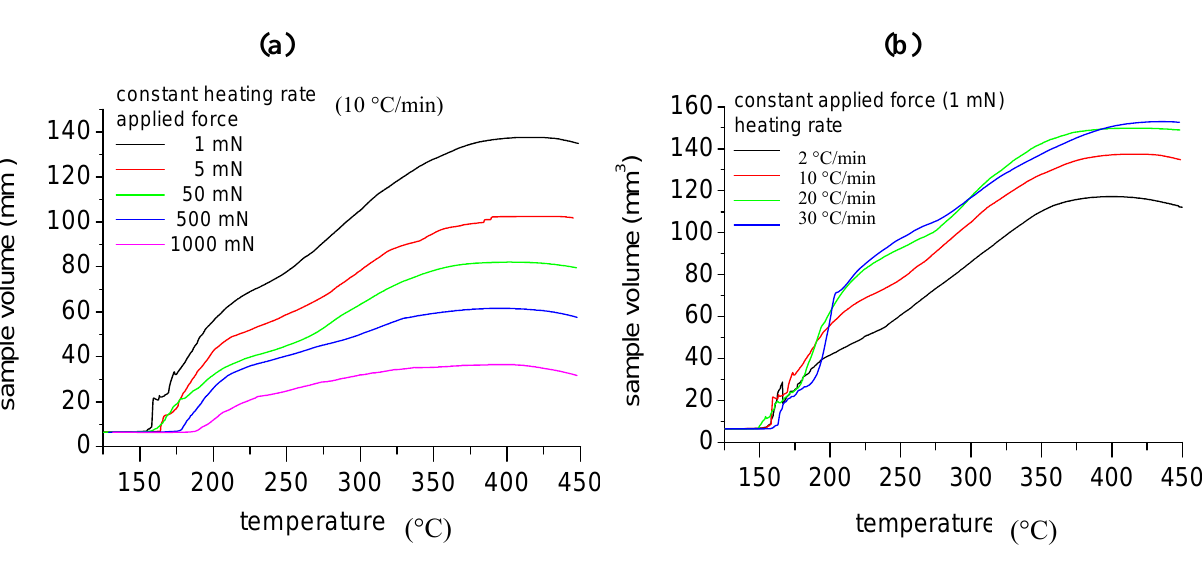
Figure 4. Themomechanical Analysis (TMA) of GIC ( a ) at different compression forces and ( b ) at different heating rates.